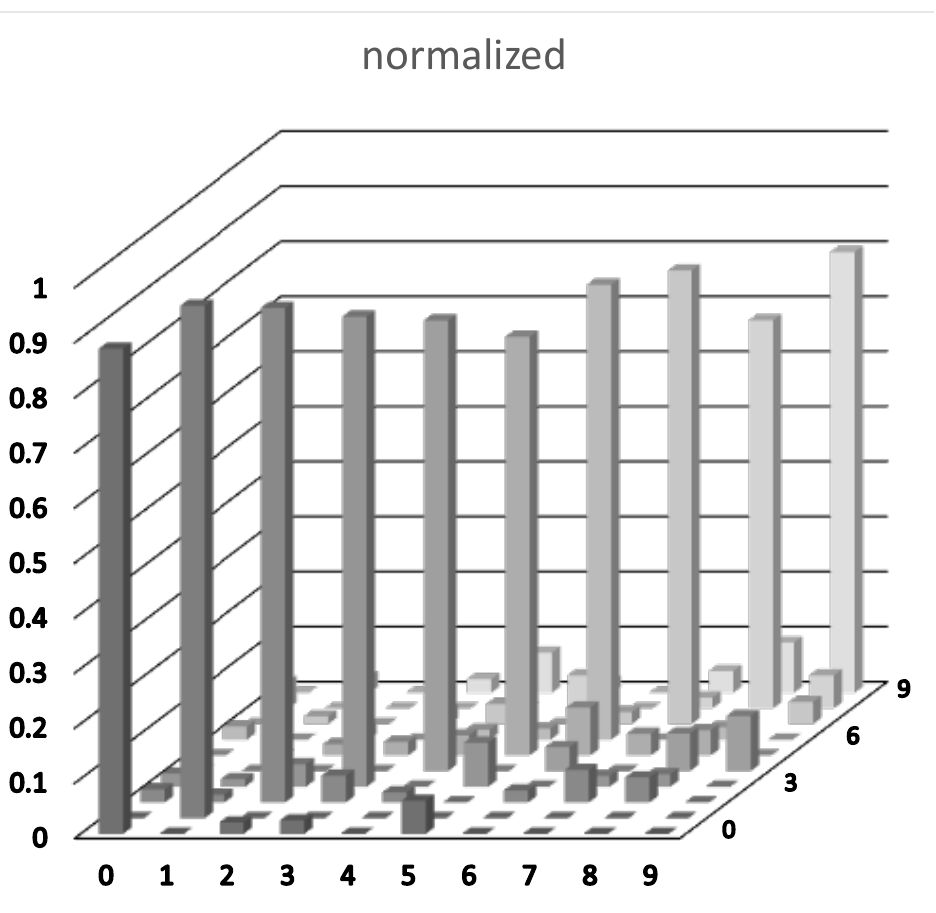
Figure 5. The x- and y-axis are the input digit-class and output digit-class, respectively. The z-axis is average normalized output response for 2500 test